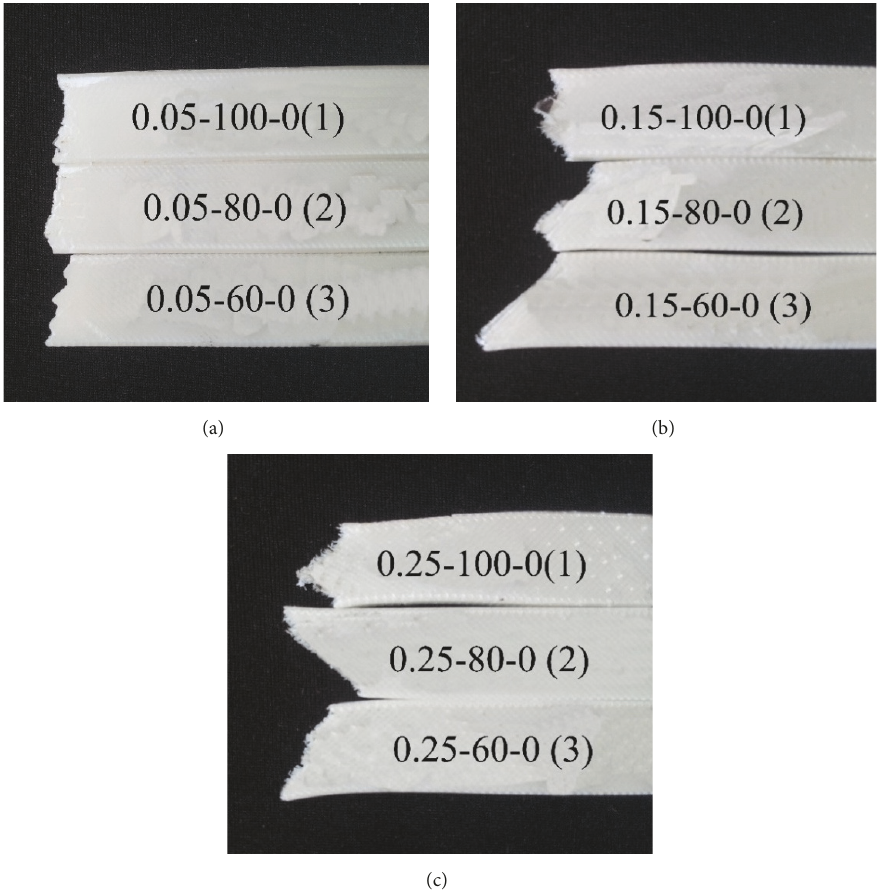
Figure 5: The failure models of the specimen with different building